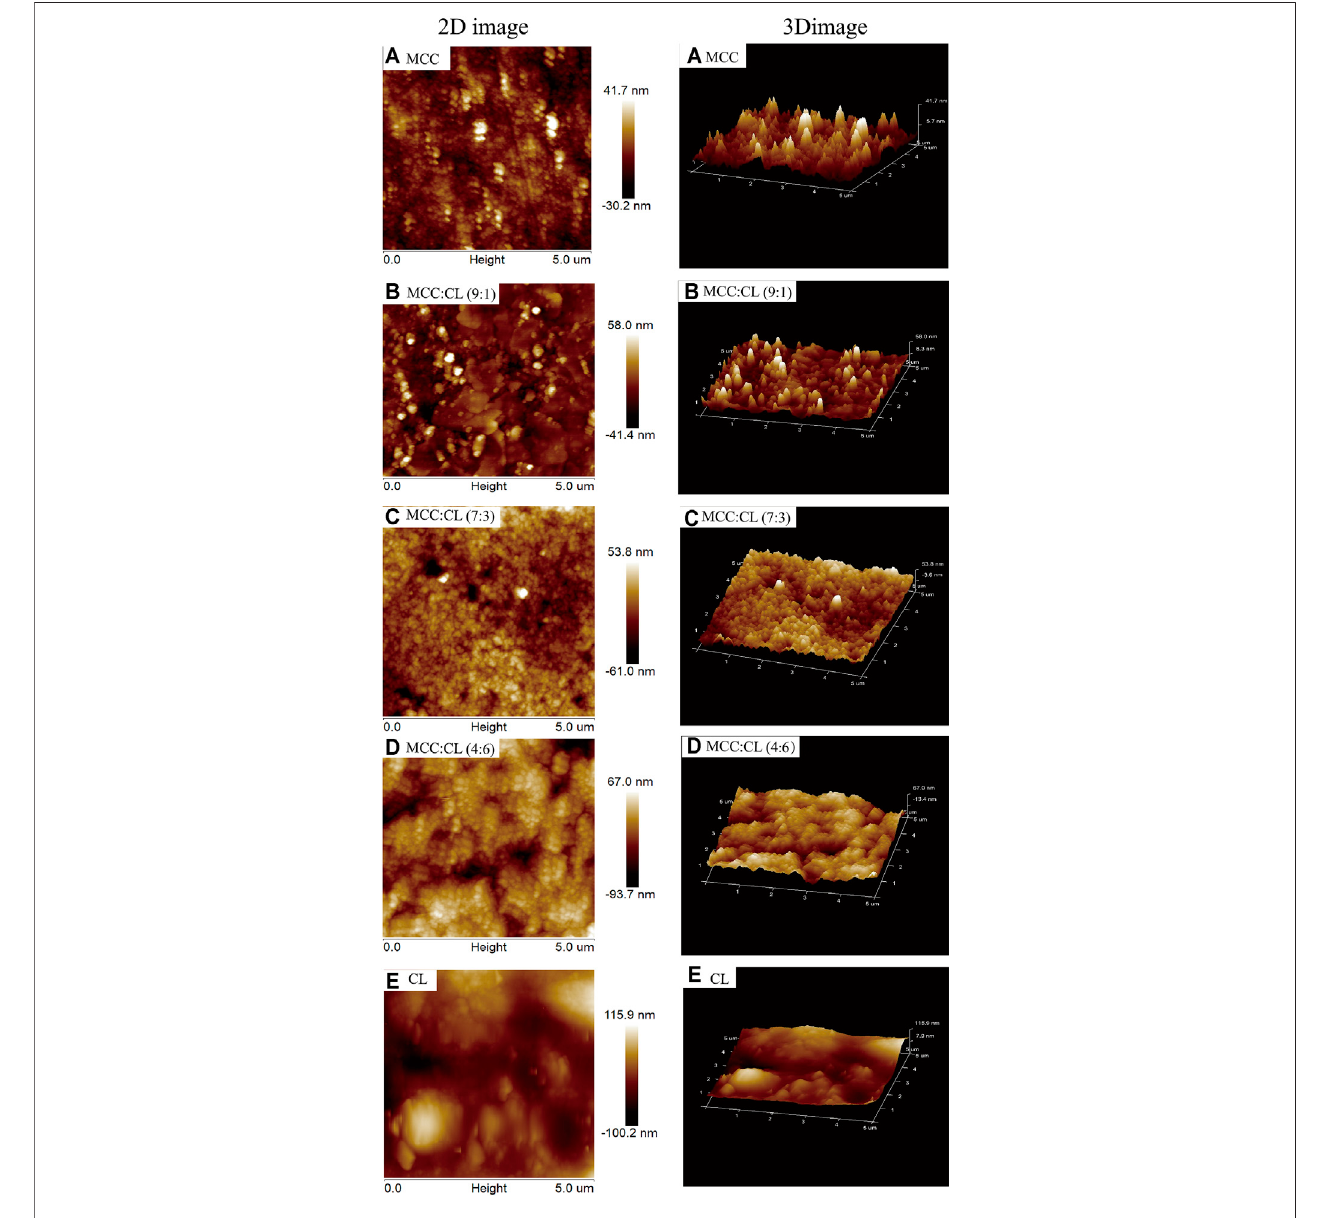
FIGURE 4 | Surface morphologies of AFM of the MCC fi lm (A) , MCC:CL (9:1) fi lm (B) , MCC:CL (7:3) fi lm (C) , MCC:CL (4:6) fi lm (D) , and CL extract (E) .